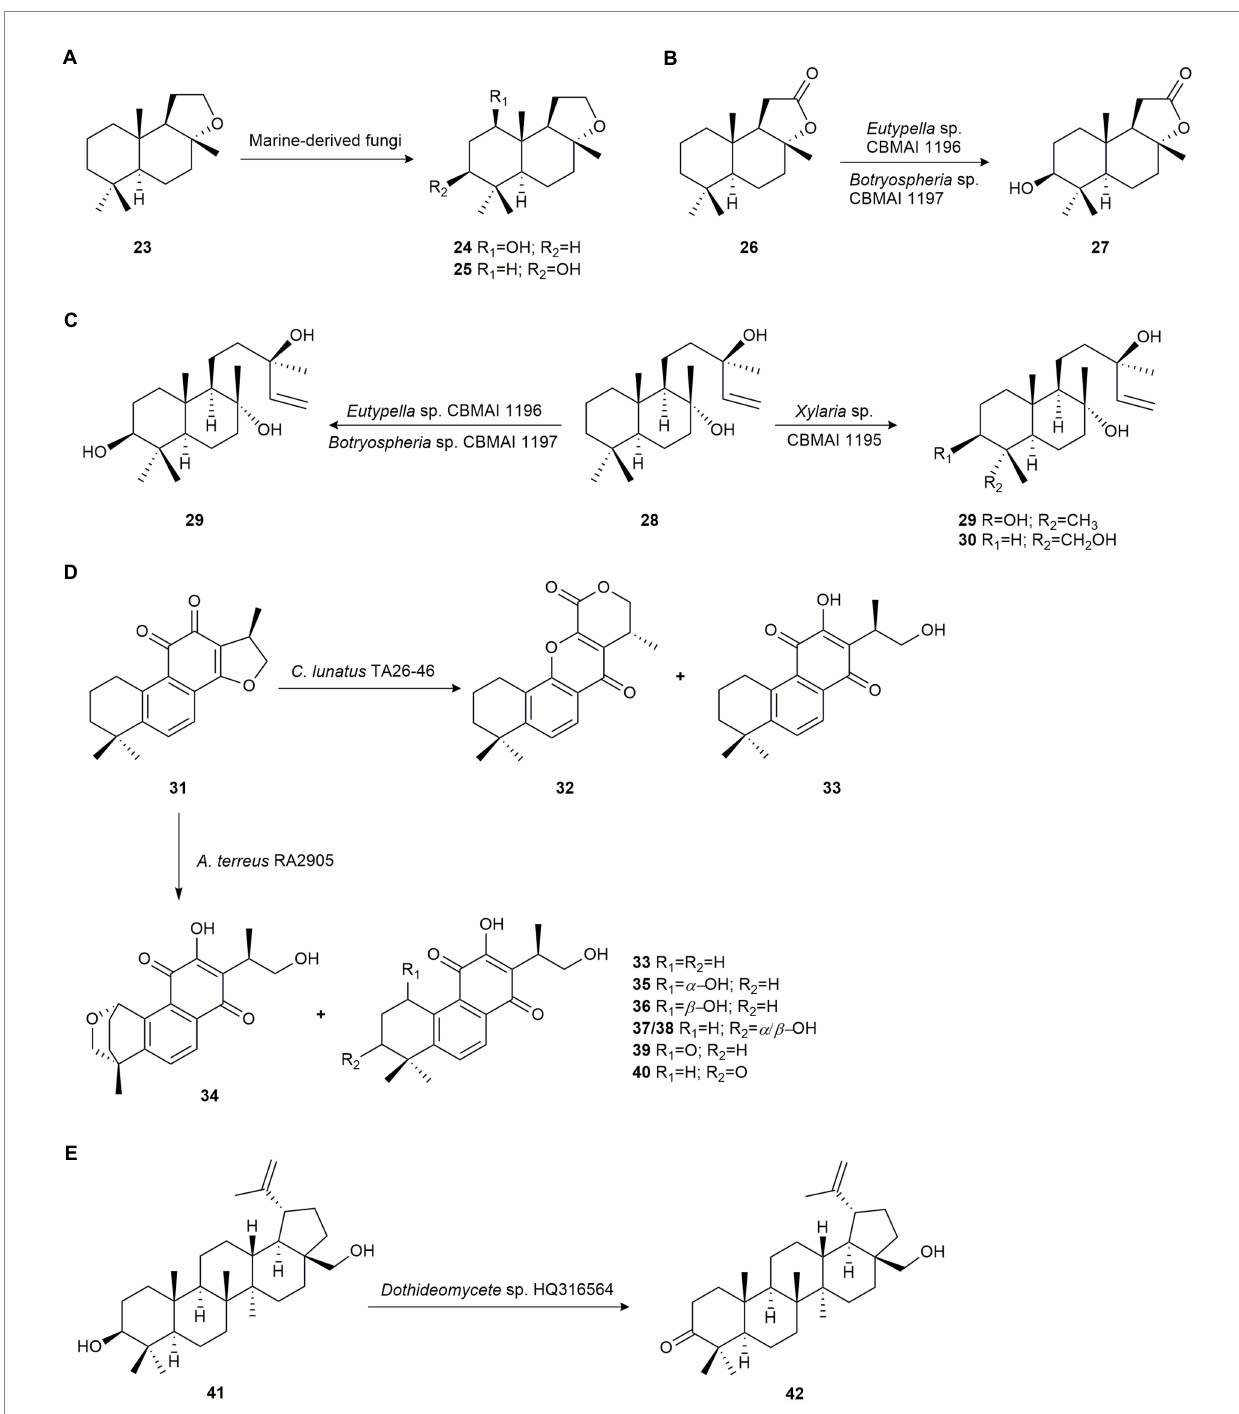
FIGURE 2 Terpene biotransformations. (A) Regioselective hydroxylation of ( − )-ambrox ( 23 ) by Aspergillus sydowii CBMAI 934, Eutypella sp. CBMAI 1196 and Botryosphaeria sp. CBMAI 1197 (Martins et al., 2015). (B) Regioselective hydroxylation of (+)-sclareolide ( 26 ) by Eutypella sp. CBMAI 1196 and Botryospharia sp. CBMAI 1197 (Martins et al., 2015). (C) ( − )-Sclareol ( 28 ) biotransformation by Eutypella sp. CBMAI 1196, Botryospheria sp. CBMAI 1197 and Xylaria sp. CBMAI 1195 (Martins et al., 2015). (D) Cryptotanshinone ( 31 ) biotransformation by Cochliobolus lunatus TA26-46 and Aspergillus terreus RA2905 (Wu et al., 2020). (E) Regioselectivity oxydation of betulin ( 41 ) by Dothideomycete sp. HQ31654 (Liu et al.,